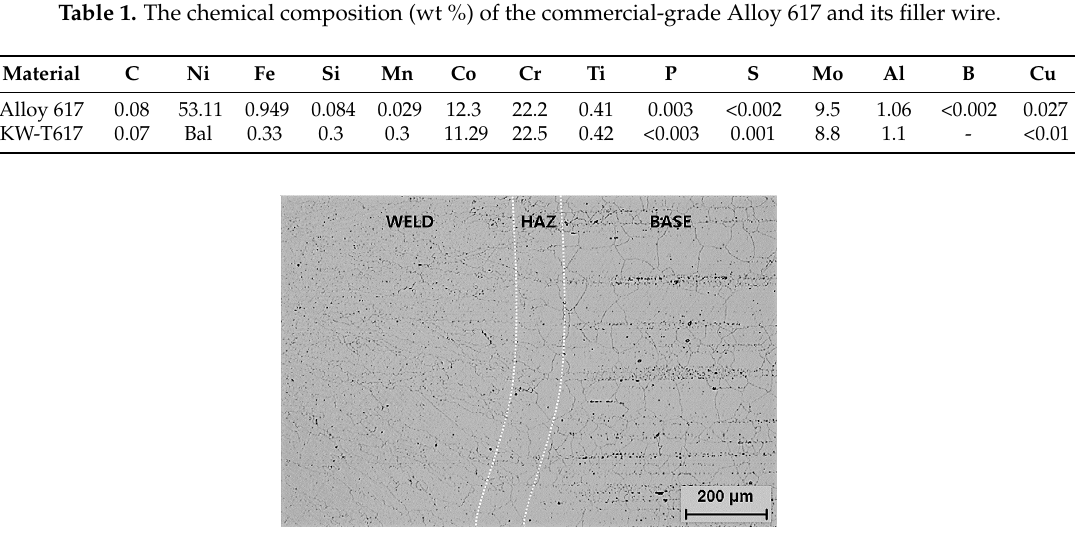
Figure 1. Optical micrograph of Alloy 617. Containing weld metal, heat-affected zone (HAZ), and base metal region. Carbides are seen along the grain boundary.